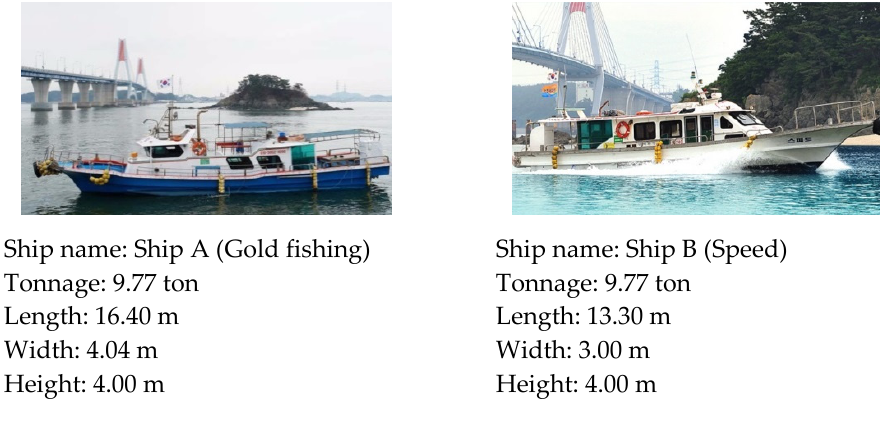
Figure 9. Photos and specifications of experimental vessels.